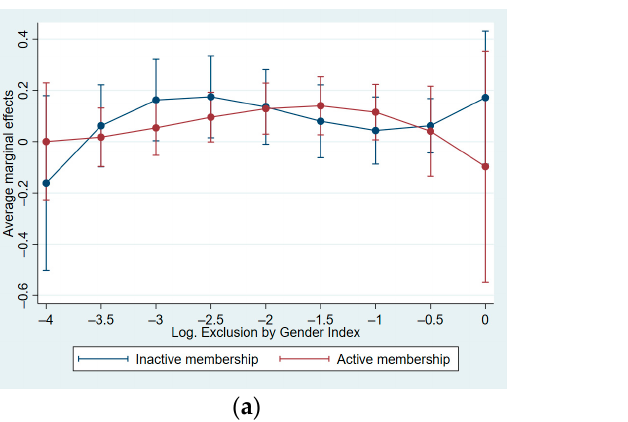
Table A6. Partial effects of sports participation on sexist gender ideologies moderated by the deciles of the WPE Index (Model 4), respectively, on the deciles of the EG Index (Model 5). Random coefficient models based on female observations from 74 countries. Source: WVS ‐ EVS ‐ data and V ‐ Dem data.